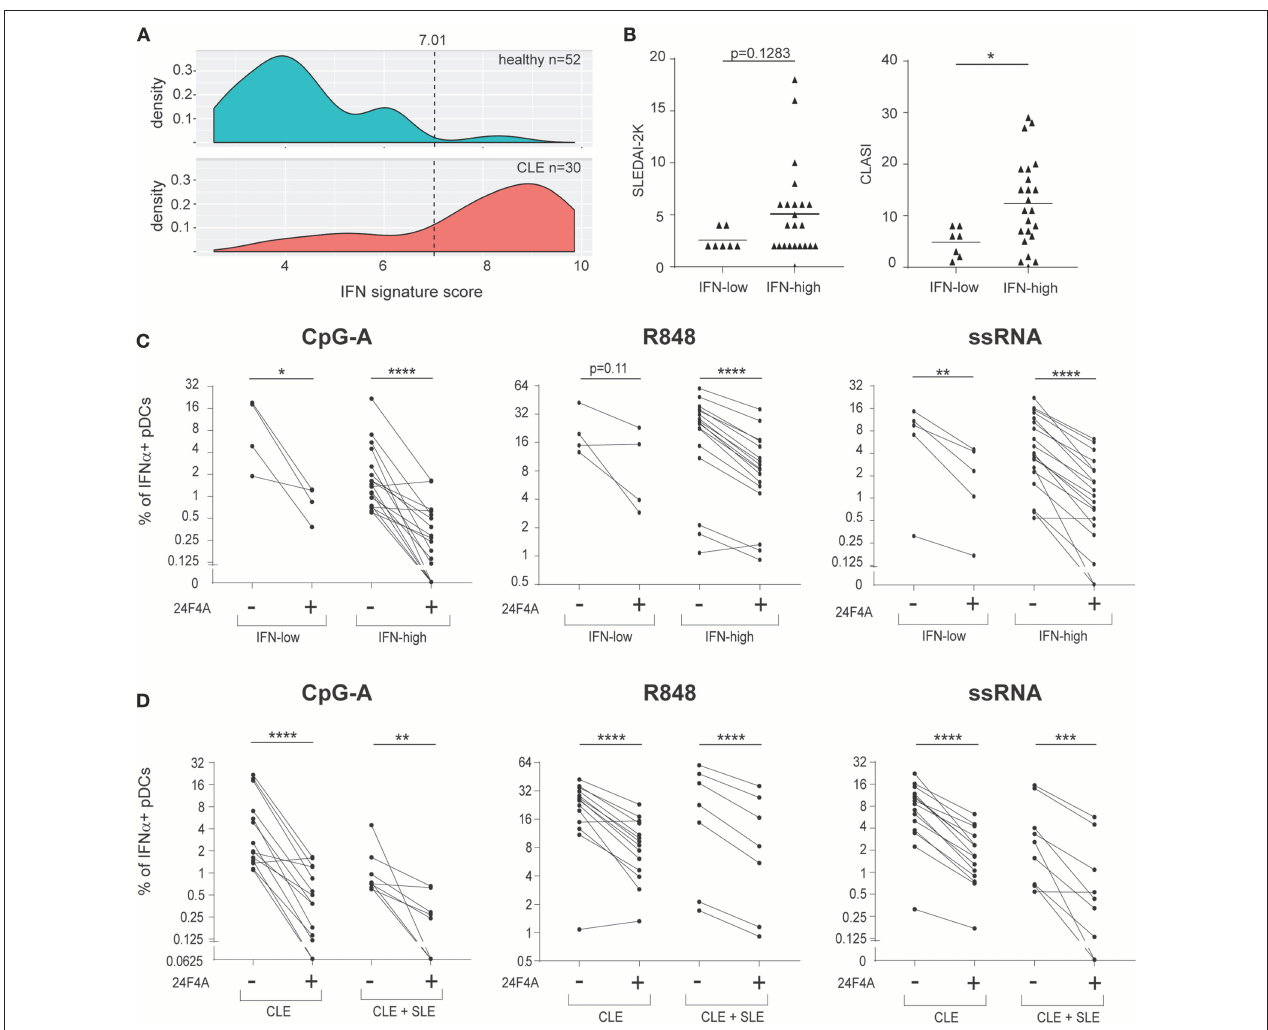
FIGURE 5 | 24F4A further reduces pDC IFN α production after CpG-A, R848 or ssRNA stimulations of PBMC isolated from CLE patients with blood IFN-high signature or concomitant SLE diagnostic. (A) Distribution of the blood IFN signature scores in healthy individuals ( n = 52) and CLE patients ( n = 30). (B) Comparison of SLEDAI2-K disease scores (left) or CLASI skin scores (right) between CLE patients with blood IFN-low and blood IFN-high signature scores. Statistical significance was assessed using Mann-Whitney test (* p < 0.05). (C) Effect of 24F4A on the percentage of IFN α -producing pDCs induced by CpG-A, R848 and ssRNA stimulations and detected by flow cytometry in PBMC from CLE patients with blood IFN-low ( n = 4 donors) or IFN-high signature ( n ≥ 17 donors). Statistical significance was assessed with a two-tailed paired Student’s t -test using log2-transformed values (* p < 0.05, ** p < 0.01, **** p < 0.0001). (D) Effect of 24F4A on the percentage of IFN α -producing pDCs induced by CpG-A, R848 and ssRNA stimulations and detected by flow cytometry in PBMC from CLE patients with or without concomitant SLE diagnostic ( n ≥ 7 donors and n ≥ 14 donors, respectively). Statistical significance was assessed with a two-tailed paired Student’s t -test using log2-transformed values (** p < 0.01, *** p < 0.001, **** p <